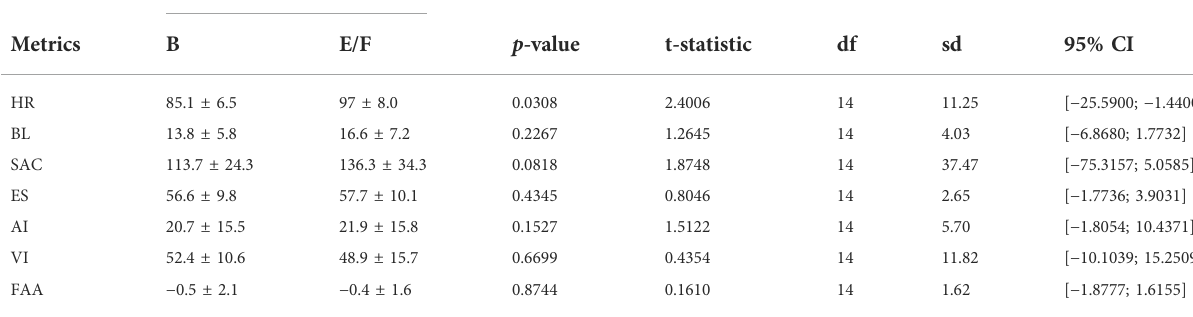
TABLE 3 Statistics of the difference between conditions for each computed metric averaged across all subjects. Mean ± Std